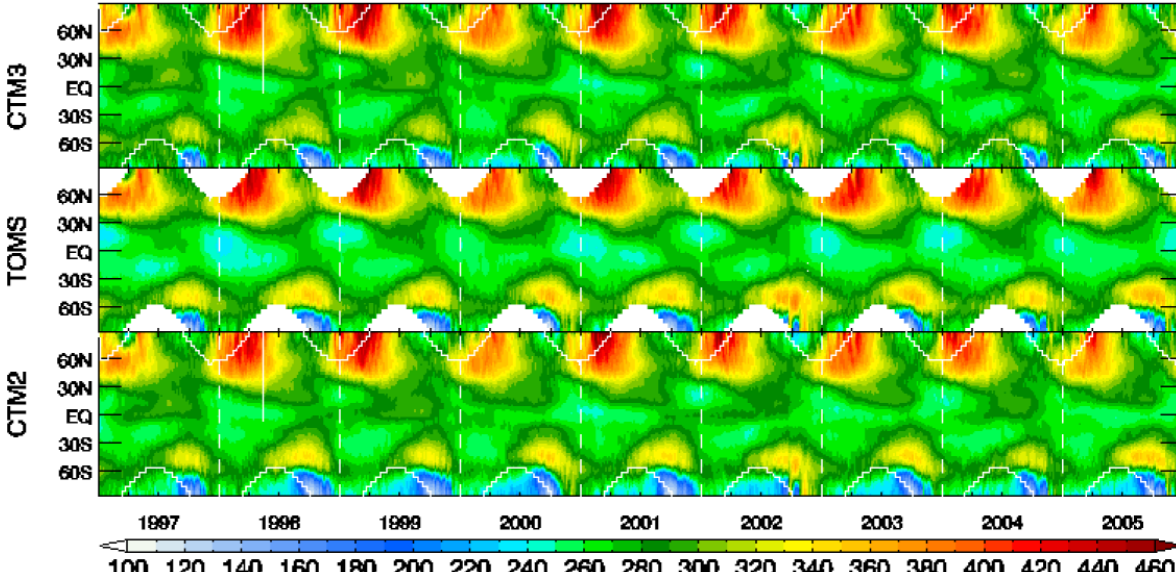
Fig. 4. Daily zonal mean total O 3 column (Dobson Units) for C3 ssn (top), TOMS (middle) and C2 ssn (bottom), from 1997 through